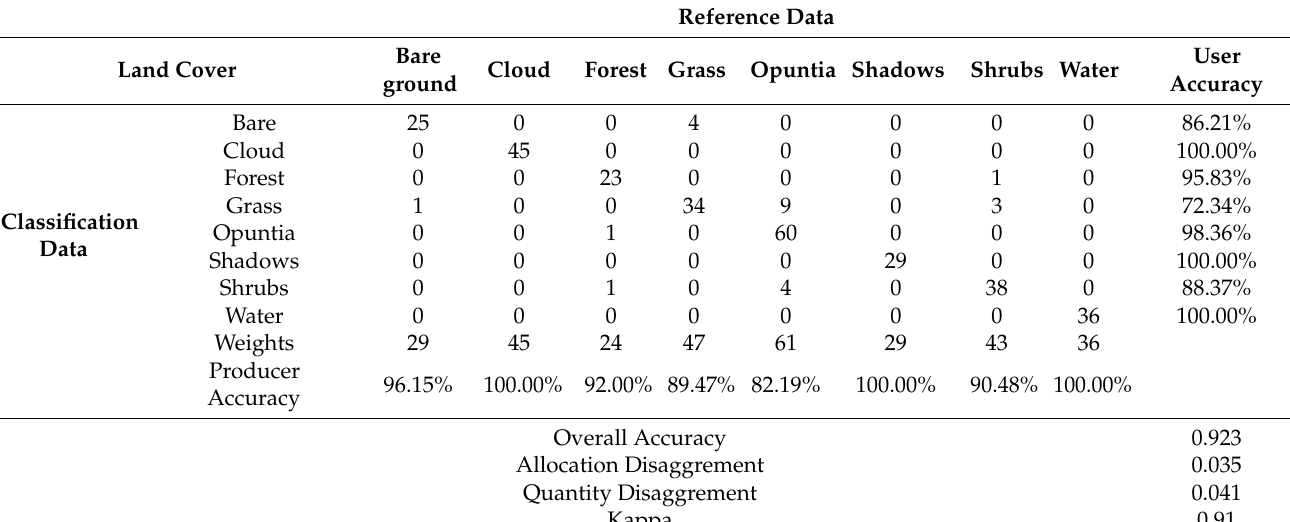
Table 8. Confusion matrix for model 2.b user’s and producer accuracy. The overall weighted accuracy is 0.92 ±